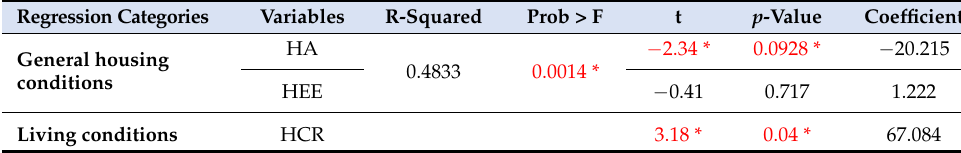
Table 6. Regression analysis results: heat-related mortality